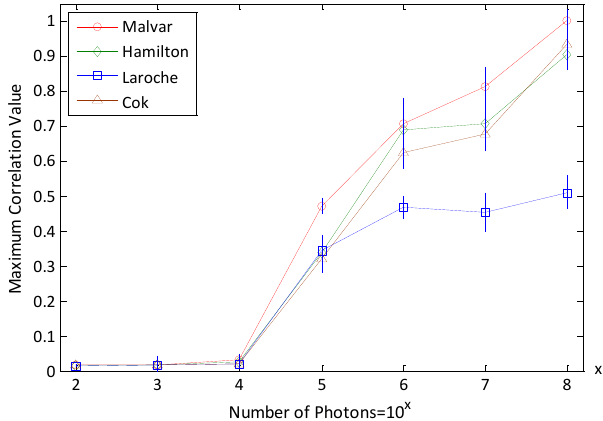
Figure 12. Maximum nonlinear cross-correlation values with different demosaicing techniques using Lena color image. [Error bars represent ±1 standard deviation of the 50 times measurement, (k = 0.3).